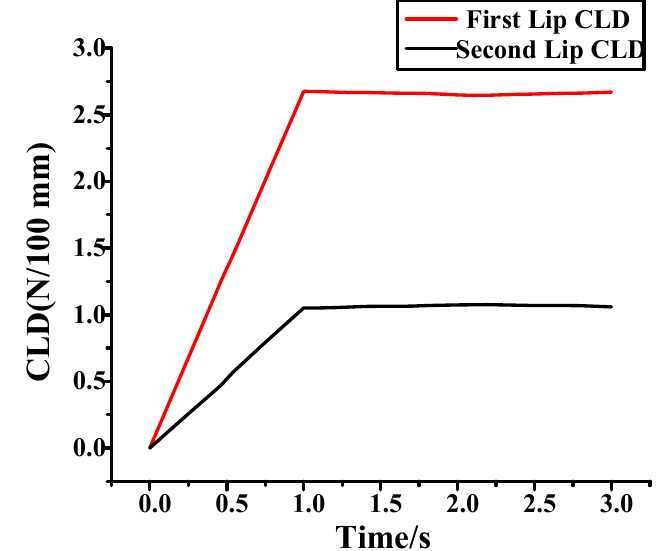
Figure 26. Change image of inner belt CLD (frictionless coefficient).